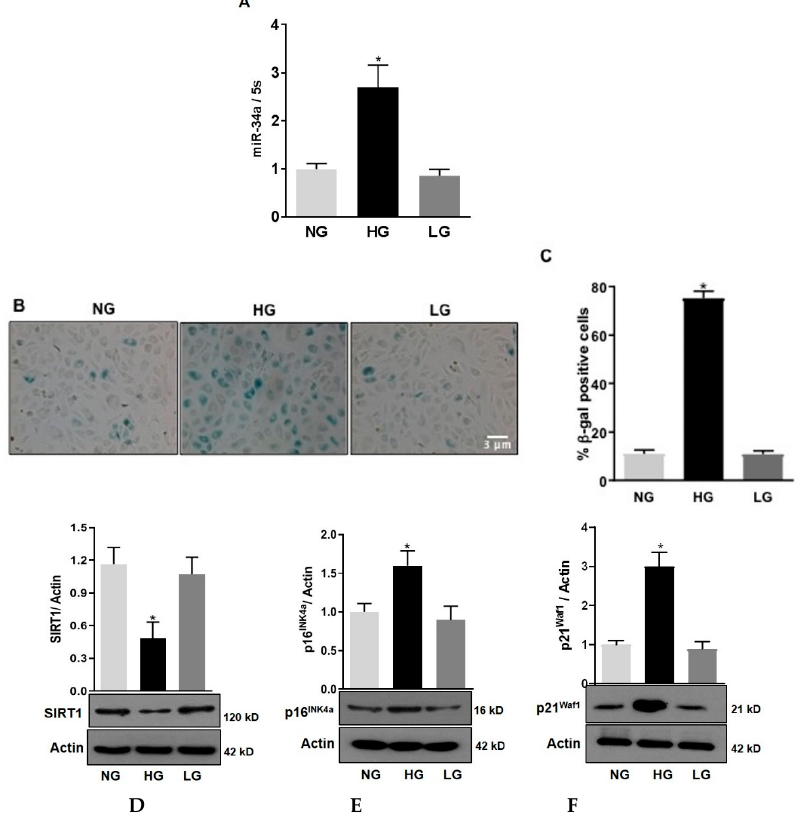
Figure 1. Effects of high glucose on miR-34a and endothelial cells senescence. ( A ) Bar histograms representing miR-34a levels measured by qPCR in HuREC treated for 48 h with high glucose (HG;